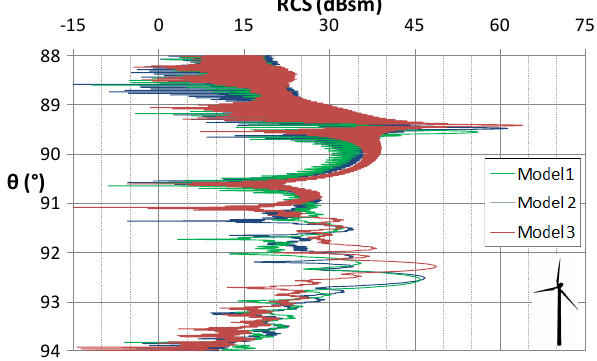
Figure 2. Vertical sections of RCS patterns ( φ = 5 ◦ ) for wind turbine models 1 to 3 at frequency 2.80 GHz. Rotor position is indicated in the lowest right corner.